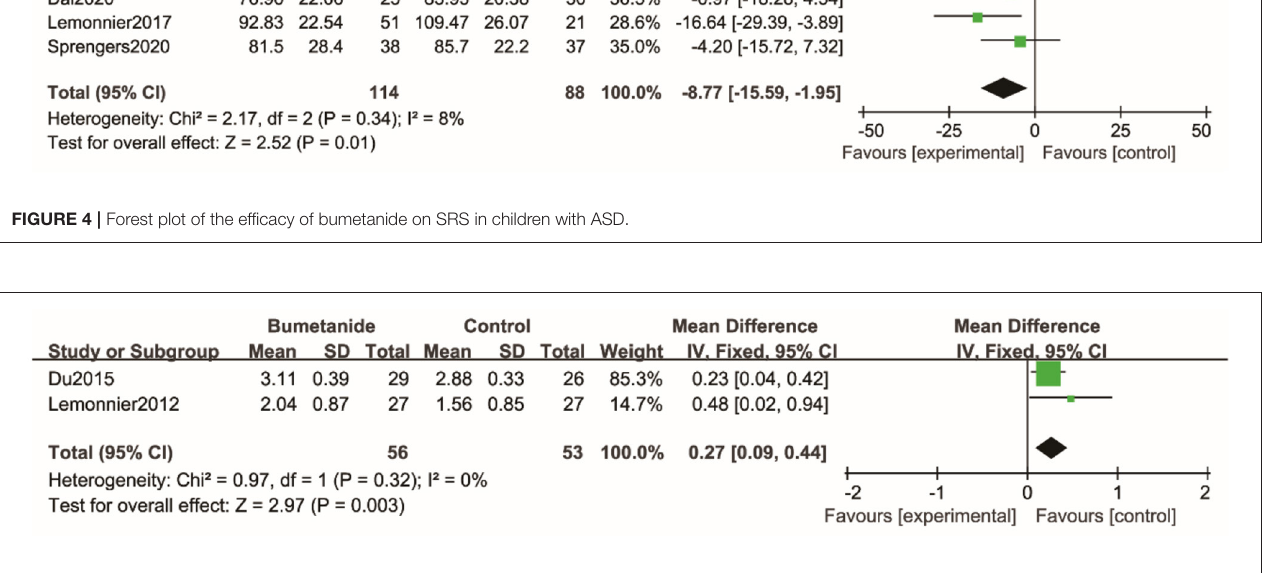
FIGURE 5 | Forest plot of the efficacy of bumetanide on CGI-E in children with